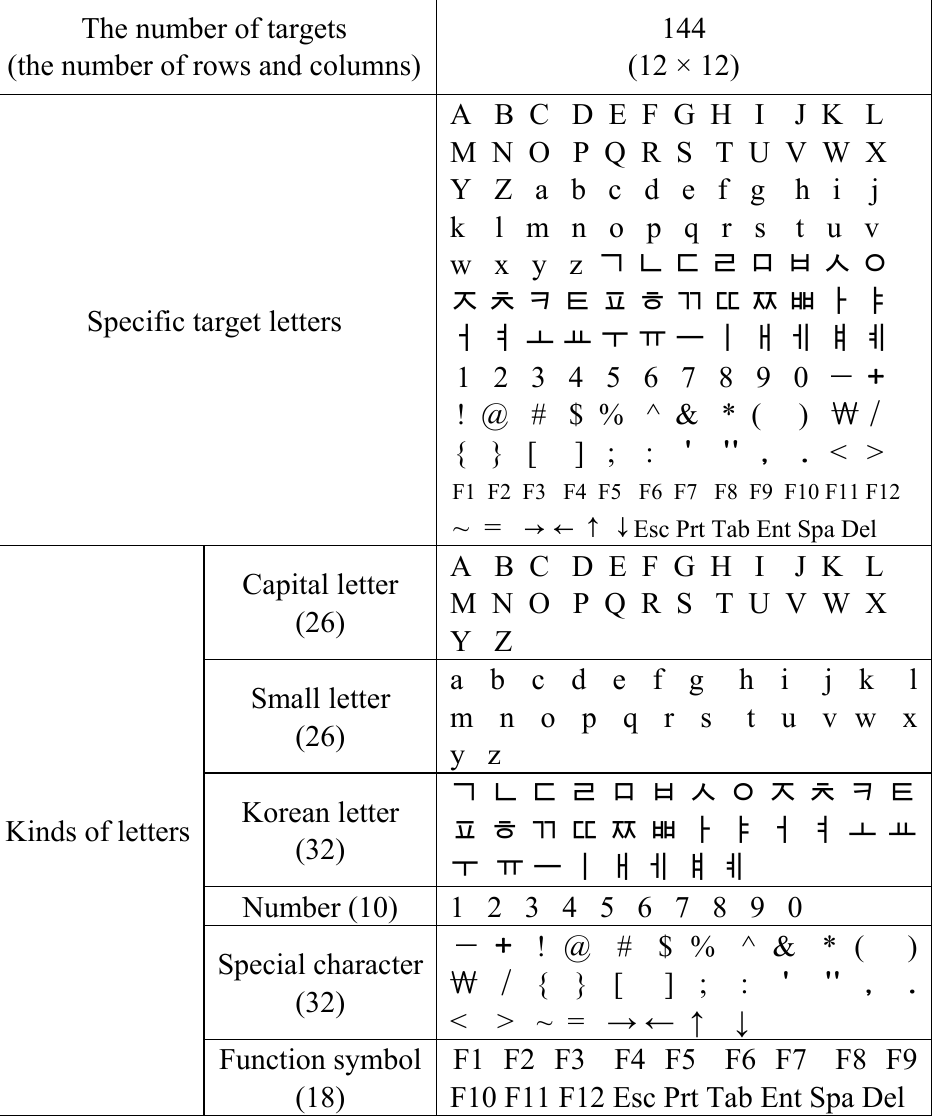
Table 1. Descriptions of the numbers of targets and specific target letters. The number of targets (the number of rows and